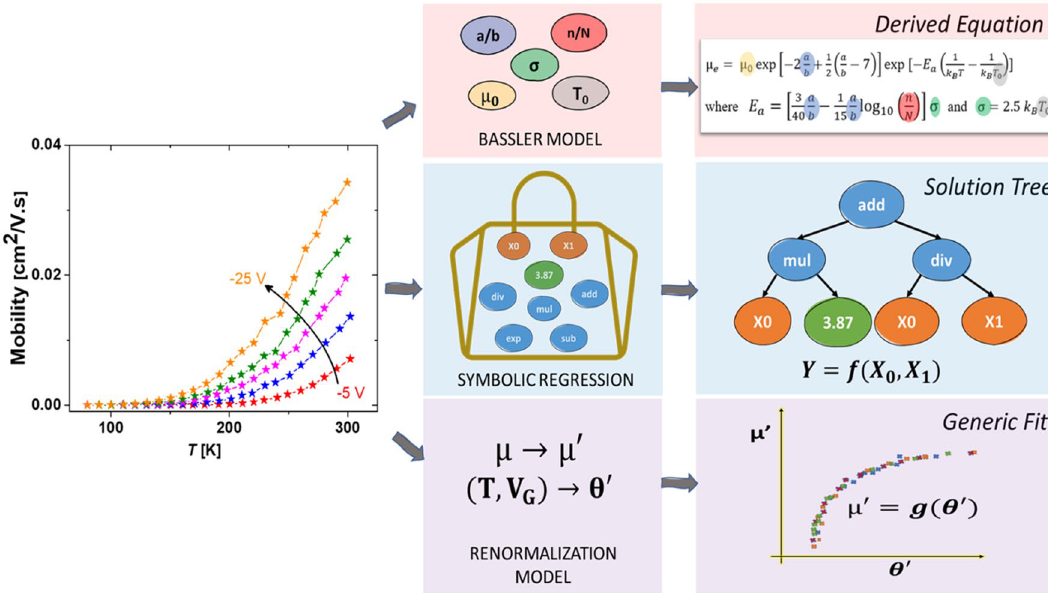
Figure 1. An overview of various approaches to extract the underlying input–output relationships from temperature-dependent field-effect mobility data. Here, the left panel consists of a representative temperature- dependent field-effect mobility data at different gate voltages. The middle panel captures the methods followed in each approach. The panel on the right shows the final solution form for each approach. For the Bassler